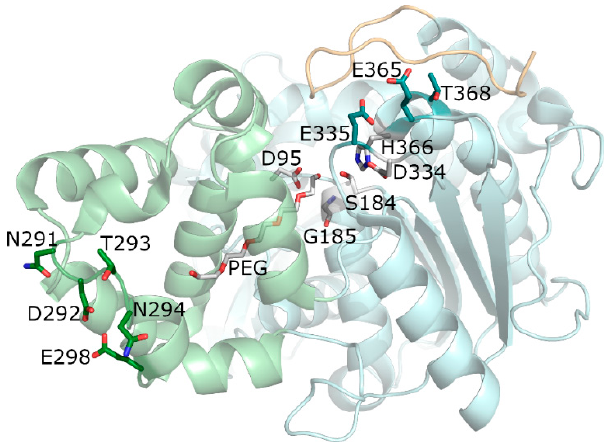
Figure 4. Predicted Mg 2+ binding sites. Mg 2+ has a positive effect on the reaction rate and enantioselectivity of CAL-A. Mapping of the predicted Mg 2+ binding sites to the CAL-A 3D structure (Protein Data Bank PDB ID: 3GUU [18]) shows two possible sites; one in the lid domain (light green) and another in the hydrolase domain (light turquoise) at the interface with the flap (wheat).